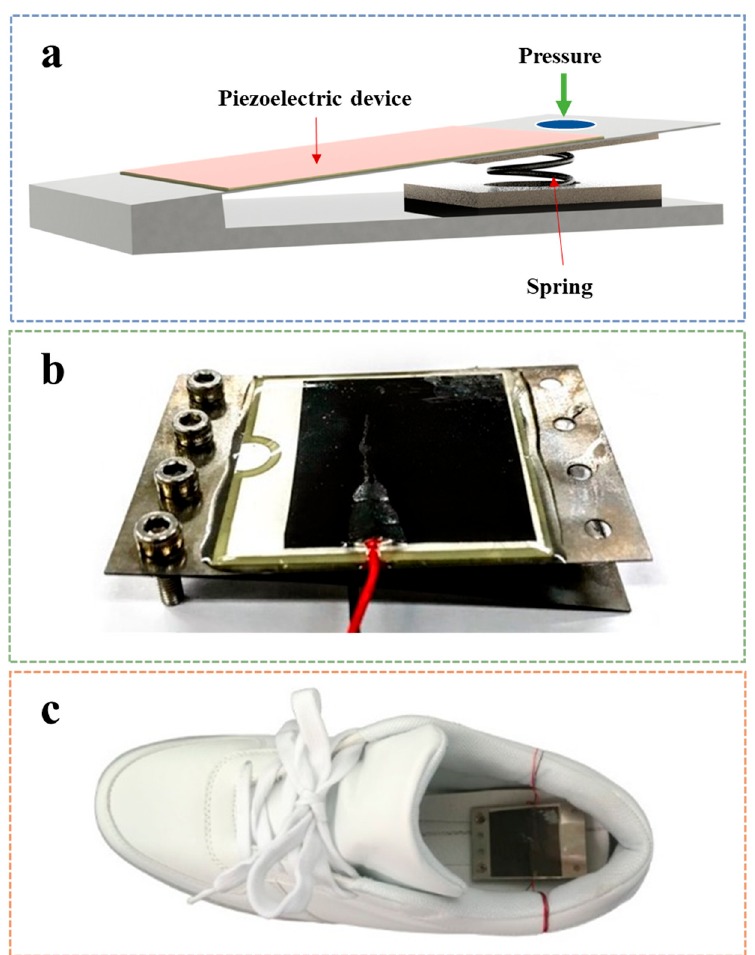
Figure 3. ( a ) Schematic and ( b ) Real image of the PEH, ( c ) Energy harvesting shoe with PEH.